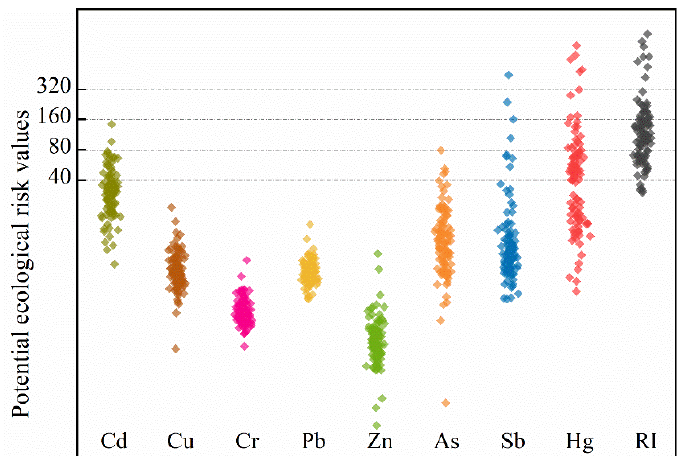
Figure 5. Pollution levels of PTEs classified by E i r and RI in the Caidi River Watershed. Each column of little squares represents the potential ecological risk value of one PTE: Cd (bronze green), Cu (brown), Cr (pink), Pb (yellow), Zn (vivid green), As (orange), Sb (royal blue), Hg (red), and RI (black).